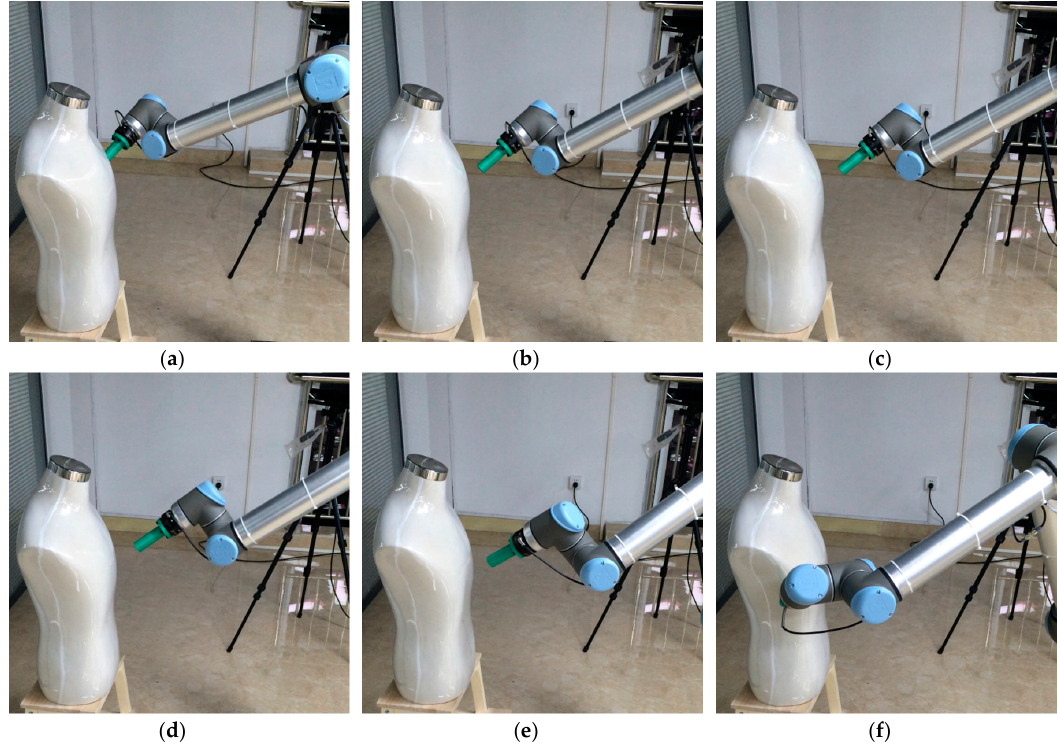
Figure 6. Path sequence with the S-RRT algorithm in static obstacle avoidance. ( a – f ) represent different states of the manipulator and static obstacle at each